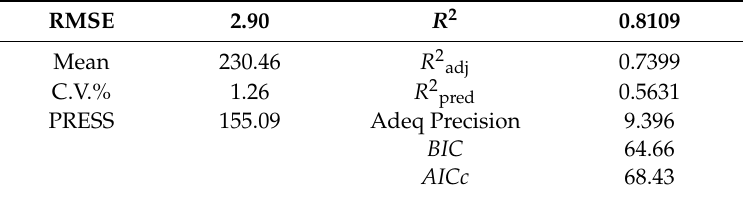
Table 8. Analysis of statistical variance.